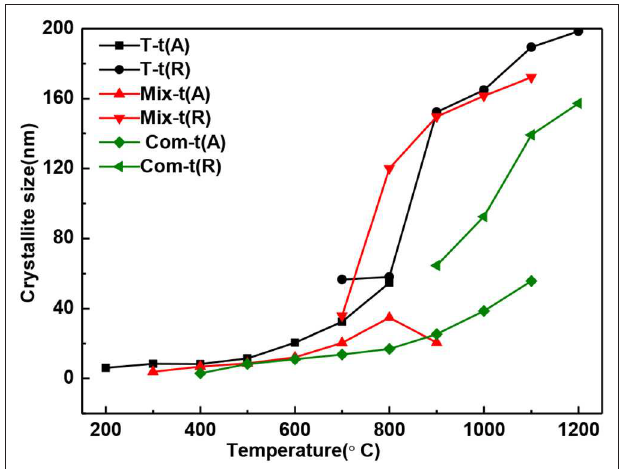
FIGURE 4 | The content of anatase and rutile in T, Mix, and Com calcinated at the different temperatures.